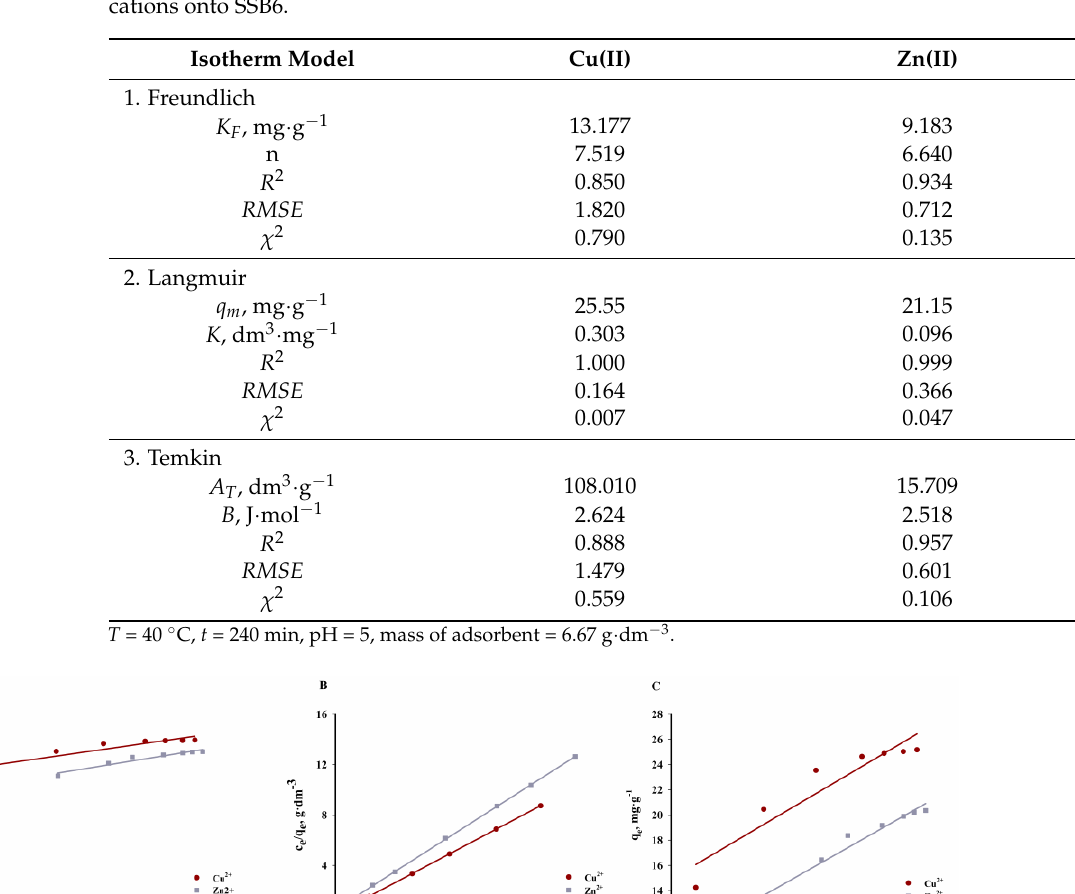
Table 9. Freundlich, Langmuir and Temkin isotherms parameters for adsorption of Cu 2+ and Zn 2+ cations onto SSB6.